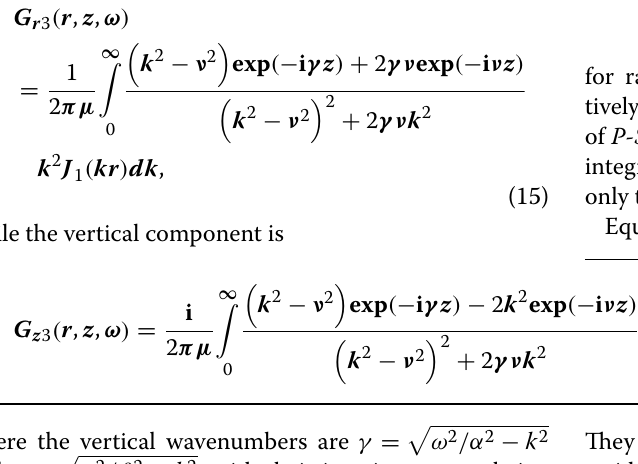
Fig. 3 Half‑space loaded on the surface. Receivers covering a square with side of 20 shear